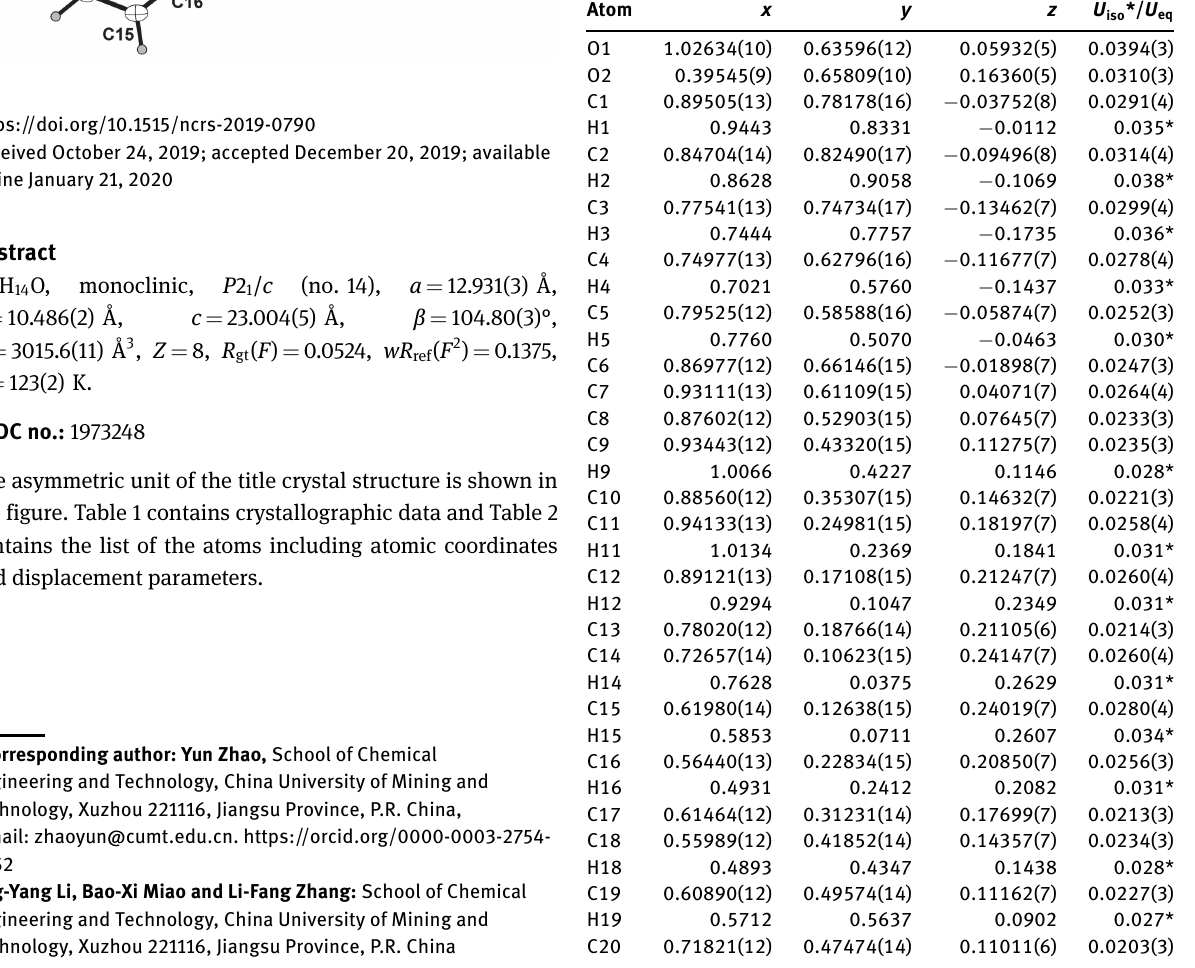
Table 2: Fractional atomic coordinates and isotropic or equivalent isotropic displacement parameters (Å 2